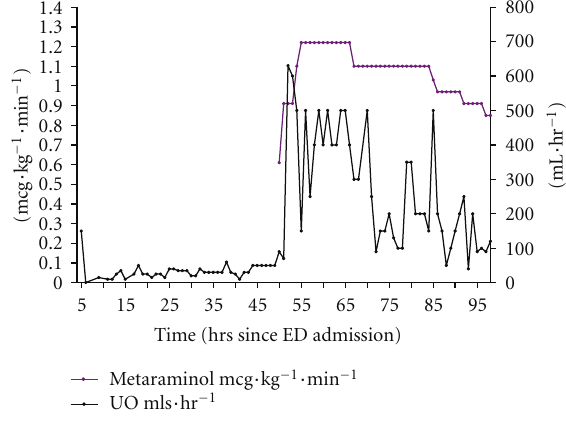
Figure 5: The e ff ect of metaraminol on urine